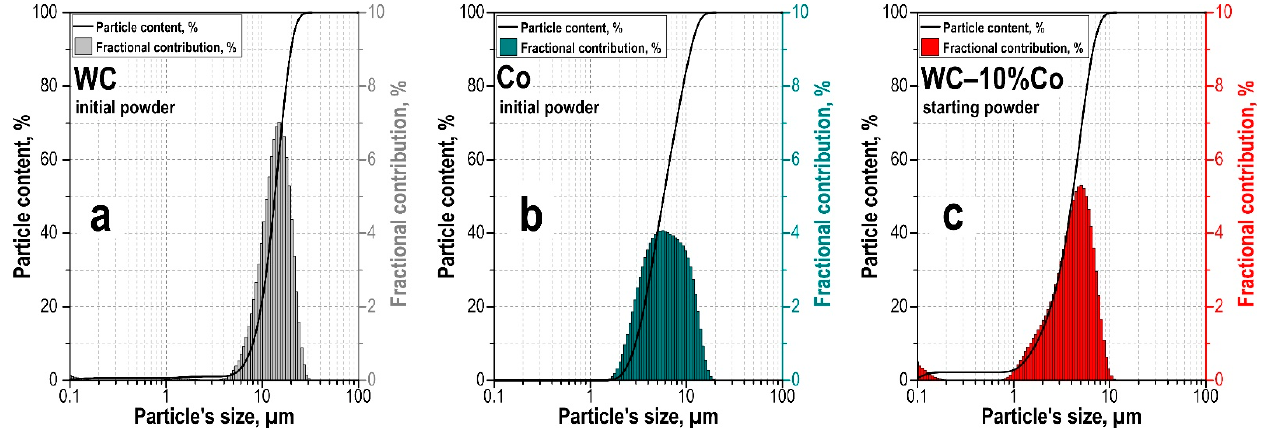
Figure 1. Particle size distribution of the initial ( a ) WC and ( b ) Co powders, as well as ( c ) after grinding the mixture WC-10wt%Co for 7 grinding cycles.